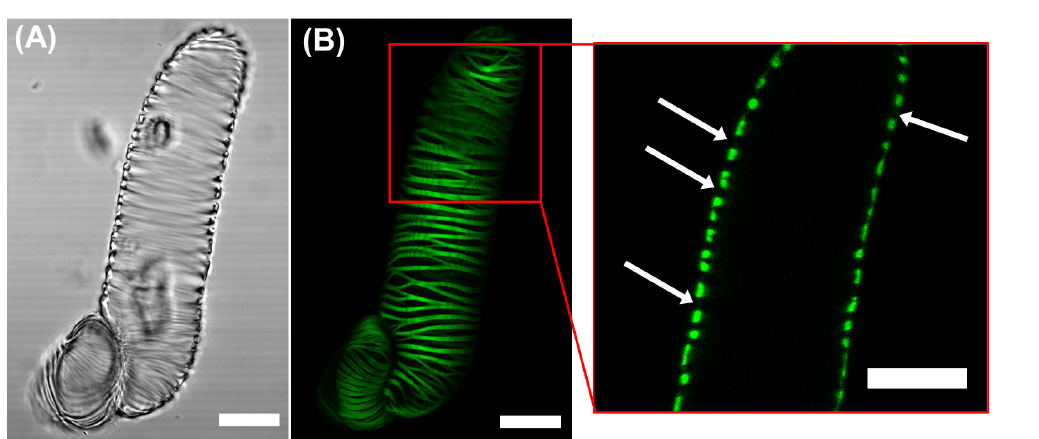
Figure A2. Transmitted and fluorescent images of an elongated VND7-inducible cell in stage 3 of transdifferentiation with visible hydrolyzed PCW. ( A ) Transmitted light image of the cell showing loss of most cytoplasmic contents. ( B ) Fluorescent image of cell highlighting location of SCW bundles. (inset) Single slice of fluorescent confocal image with arrows pointing to gaps in the cell wall, showing that we indeed have loss of PCW material in some locations. All scale bars 20 µ